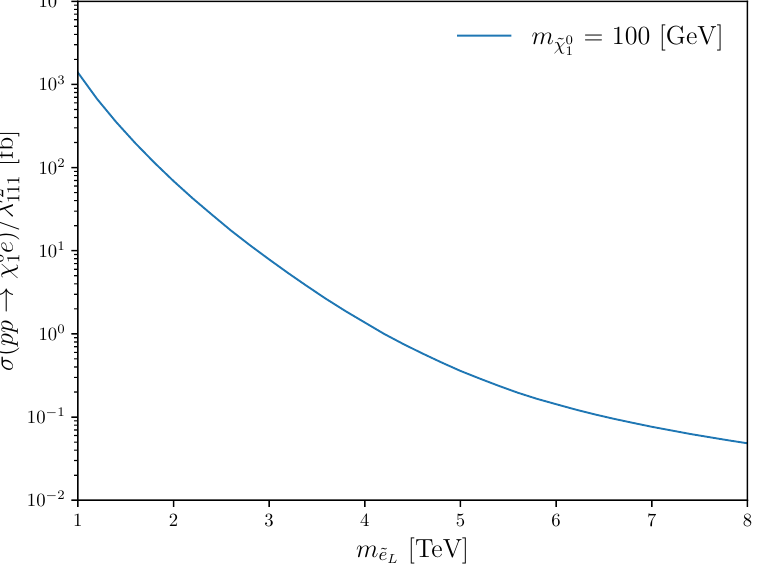
as a function of m 111